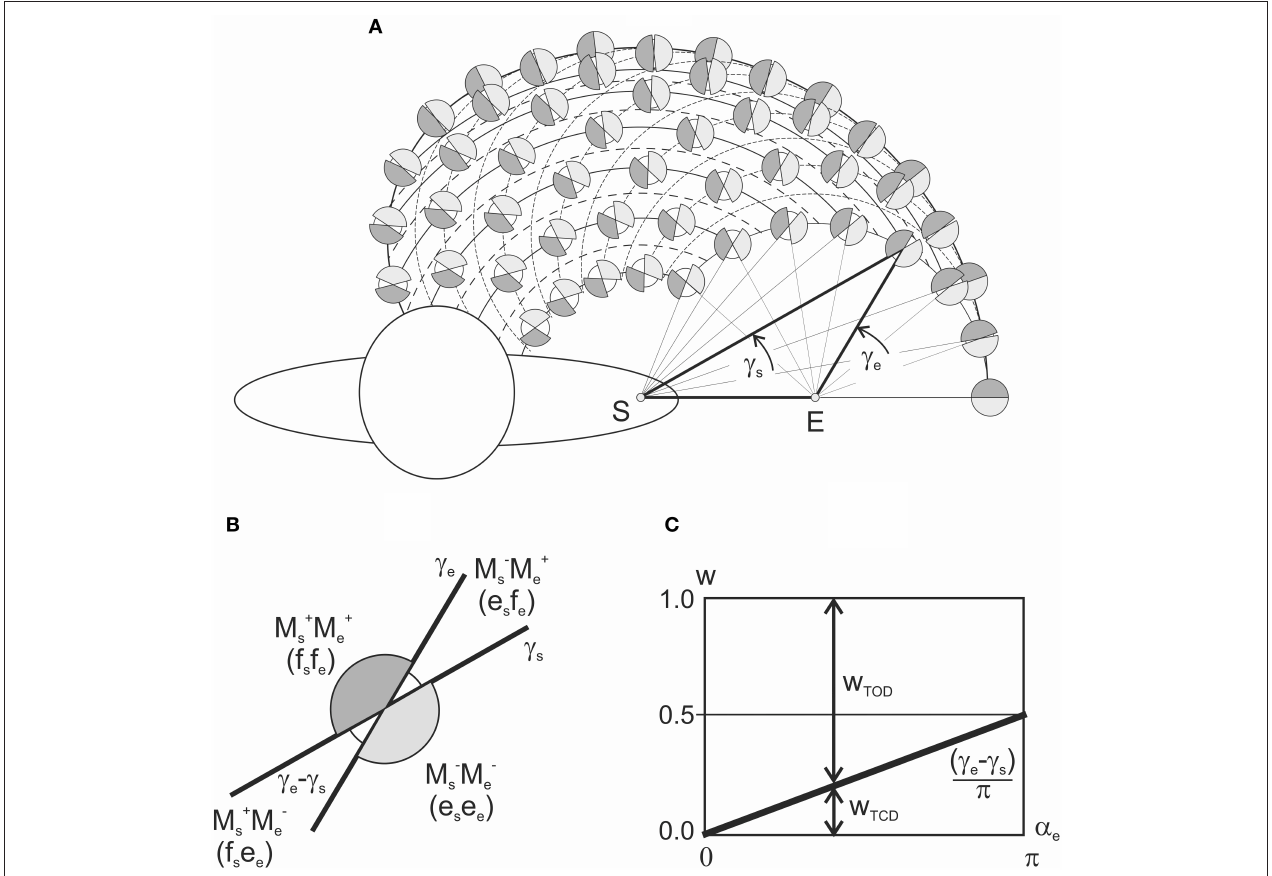
FIGURE 6 | Schematic presentation of the patterns of the torques of coinciding and opposing directions (TCD, TOD) in dependence on the positioning of the end-points within the working space. (A) The torque combinations are depicted by the shadowed (TCD) and white (TOD) sectors at the circles interposed in the nodes of intersection of the “shoulder” and “elbow” end-point traces with fixed values of α e and α s , respectively. (B) Combinations the joint torques and related patterns of loading of the flexor (f) and extensor (e) muscles belonging to different joints. (C) Changes in the TCD and TOD weights in dependency on the elbow joint angle (plot in accordance with Equation